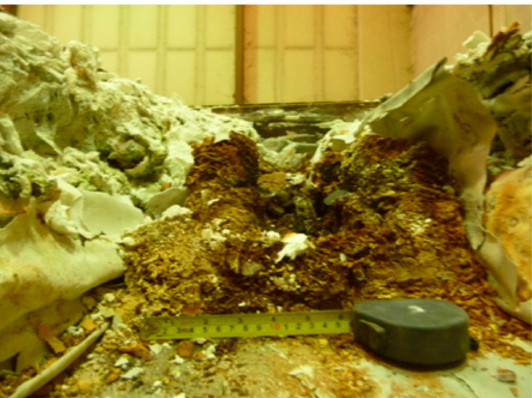
Figure 5. The coal blocks in the experimental generator after the gasification process (Source: own elaboration.